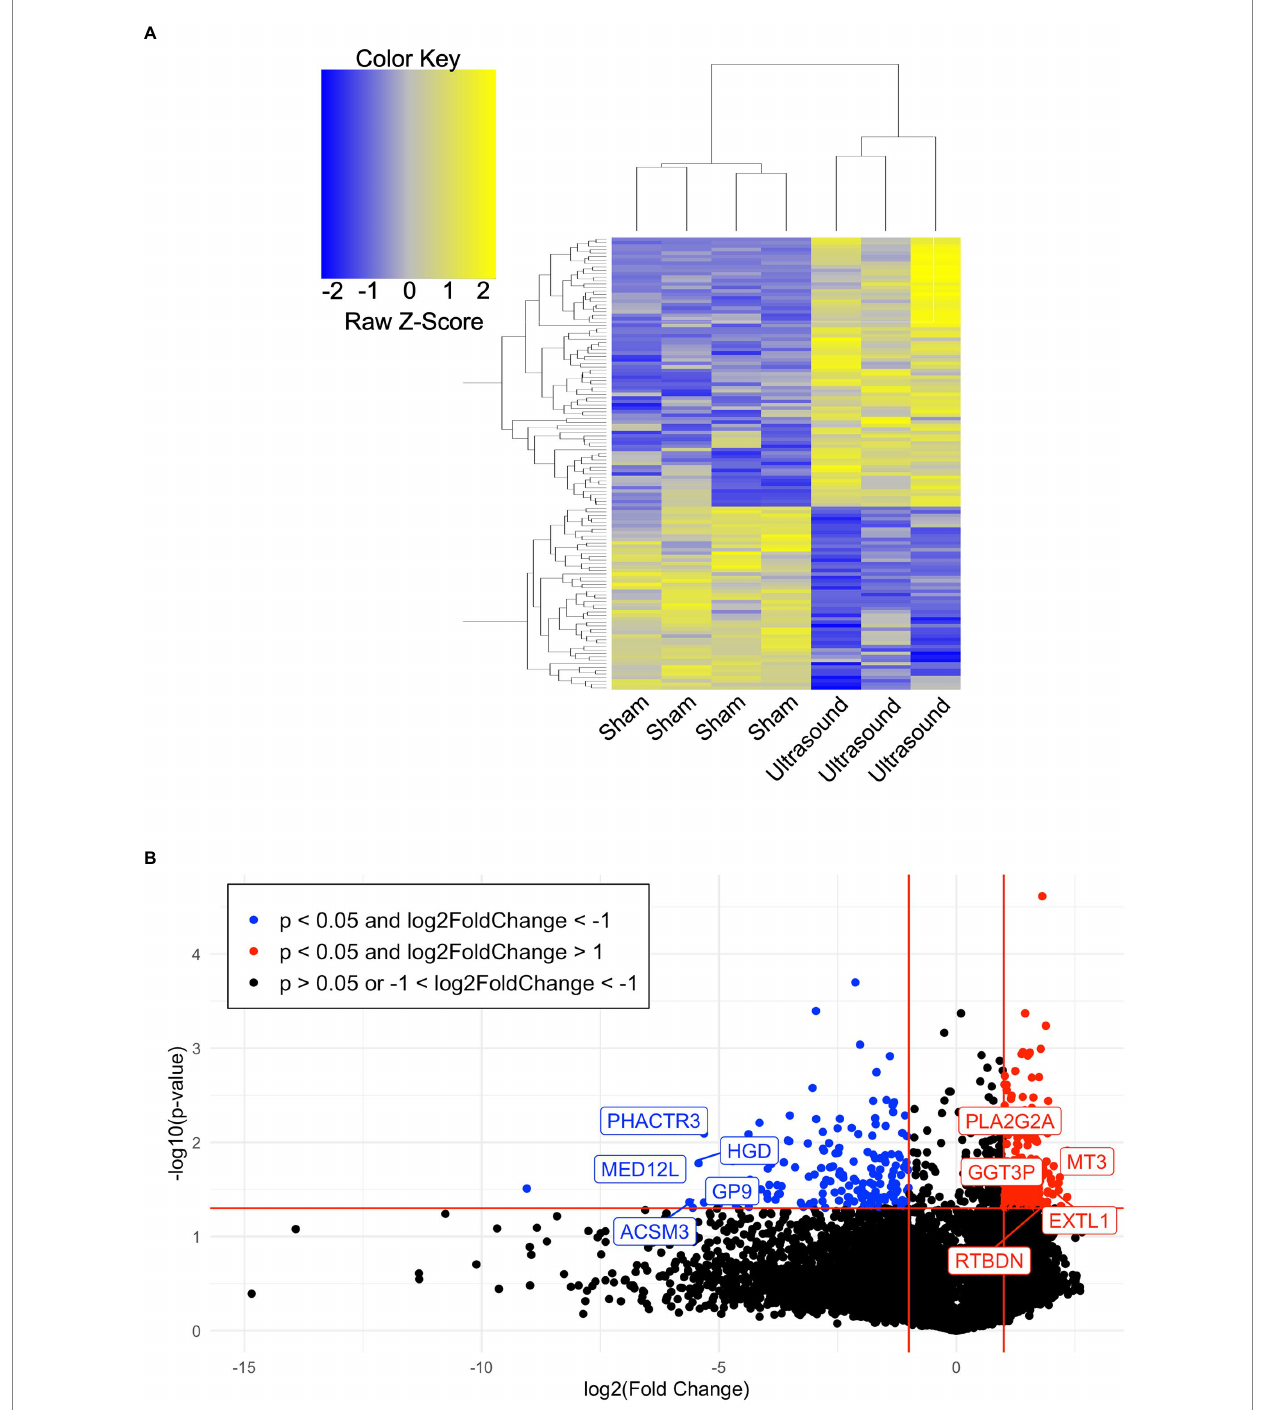
FIGURE 2 (A) Hierarchical clustering of DEGs ( p < 0.05, absolute value of fold change >4) when comparing the ultrasound to sham group. (B) Volcano plot of value of p vs. fold change (FC) of gene expression in ultrasound compared to sham group. Lines indicate FC greater than 2 and p < 0.05 using moderated T-test with Benjamini Hochberg FDR multiple correction